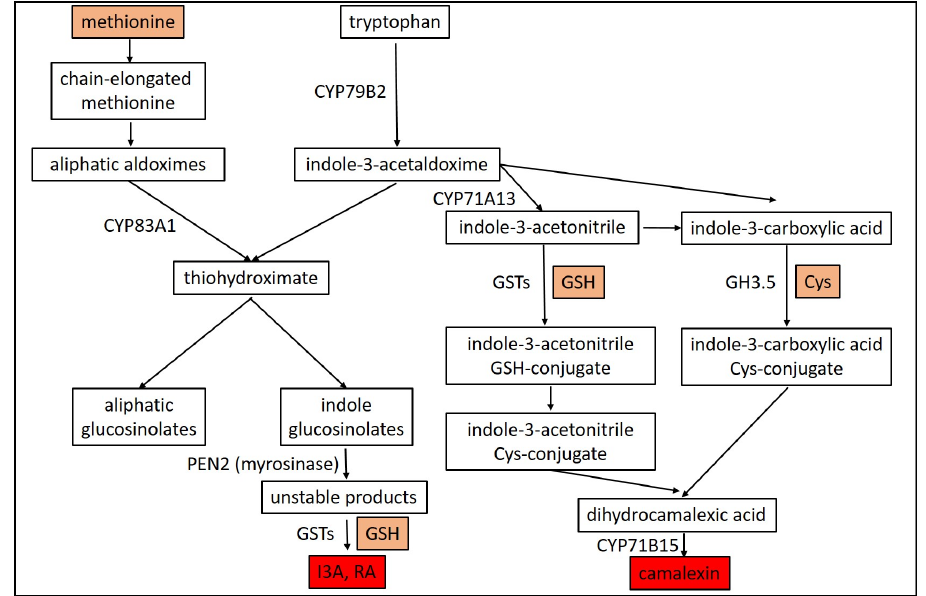
Figure 4. Glutathione (GSH) and cysteine (Cys) are involved in the in planta biosynthesis of camalexin and indol glucosinolates, compounds that contribute to resistance to fungal infections. CYP79B2, CYP71A13 and CYP71B15 = cytochrome P450 enzymes required for camalexin biosynthesis from tryptophan in Arabidopsis thaliana ; CYP83A1 = a cytochrome P450 monooxygenase responsible for the aliphatic glucosinolate pathway; GSTs = glutathione-S- transferases; GH3.5 = acetyl-amido synthetase; I3A, RA = end products of PEN2-mediated indol glucosinolate hydrolysis. For further explanations and details see the text.